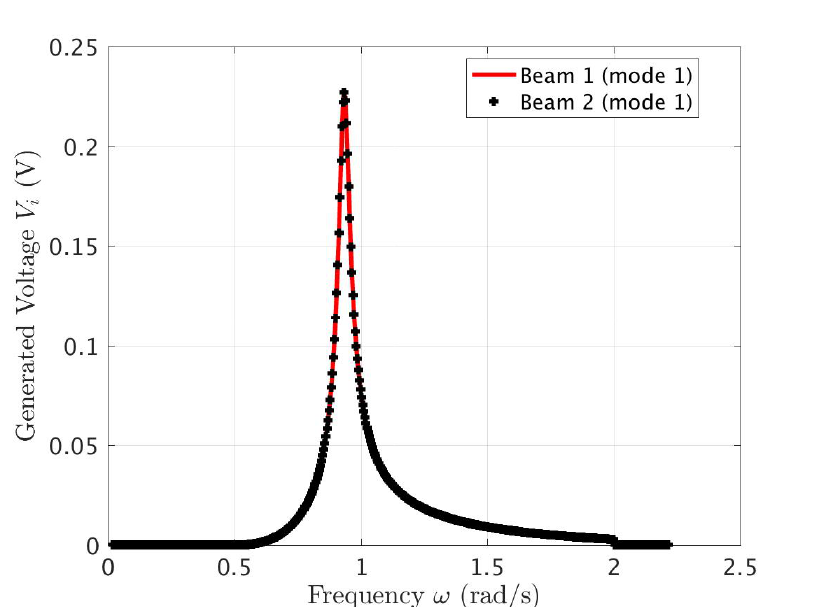
Figure 11. Voltage produced by Galfenol strips on each beam in response to an irregular wave spectrum (Pierson–Moskowitz, H s = 1.0 m, T e = 5.0 s). Beams fit the deck support loosely.